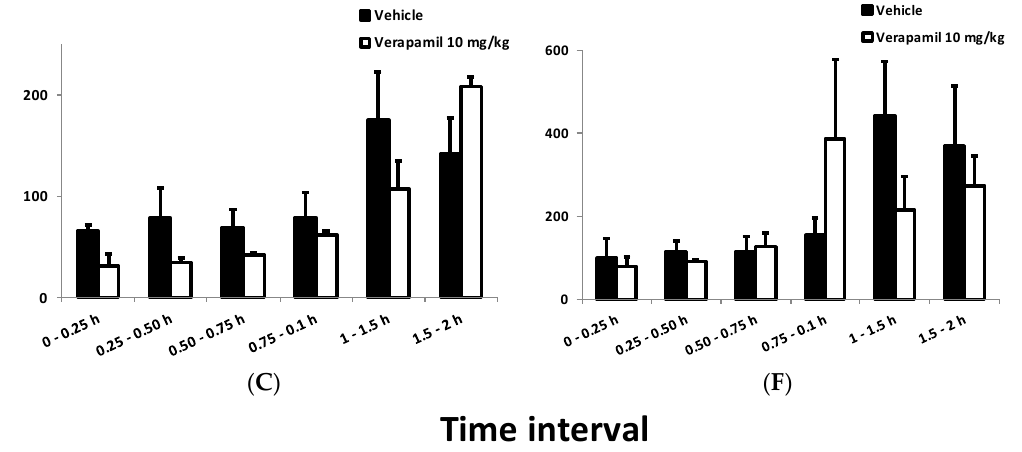
Figure 4. Amount of CP-I and CP-III excreted in bile at different time intervals in the presence ( □ ) and absence ( ■ ) of modulators. Biliary excretion profile of endogenous CP-I and CP-III in male Sprague Dawley (SD) rats following intravenous administration of various modulators. All animals received saline (0.9% NaCl) first then modulator after collection of bile at designated time points. ( A1 , D1 , A2 , D2 ); represent biliary excretion profile of CP-I and CP-III in male SD rats treated with mitoxantrone at 6 and 15 mg/kg, respectively. ( B , E ) represents biliary excretion profile of CP-I and CP-III in male SD rats treated with progesterone at 1 mg/kg. ( C , F ) represents biliary excretion profile of CP-I and CP-III in male SD rats treated with verapamil at 10 mg/kg. All the data values presented in mean and SD of single experiment performed in three animals.